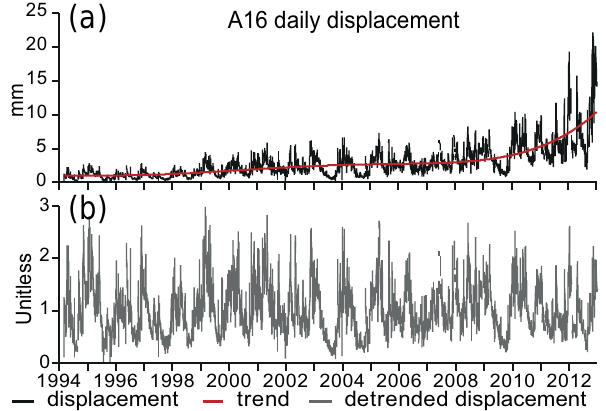
Figure 4. Trend removal of A16 extensometer displacement data. (a) A16 displacement data and the fourth-order polynomial curve fitting considered as the displacement trend; (b) A16 detrended data (unitless) corresponding to A16 displacement data for which the trend is removed by a multiplicative method.